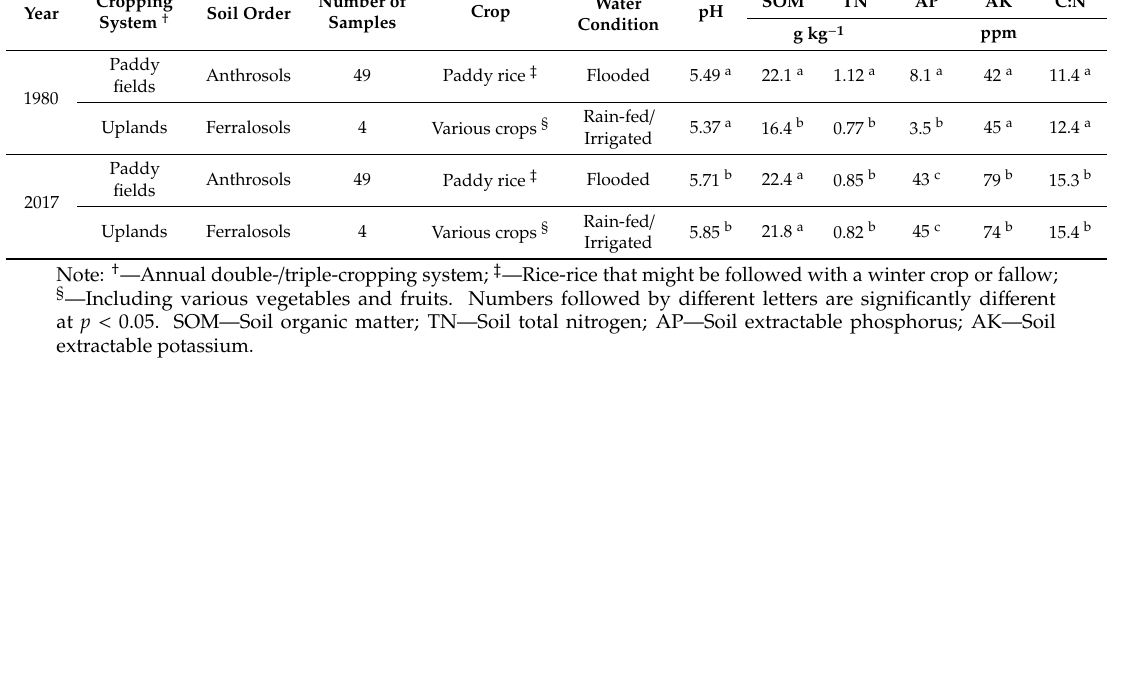
Table 2. Topsoil (0–20 cm) attributes and their differences between paddy fields and uplands.